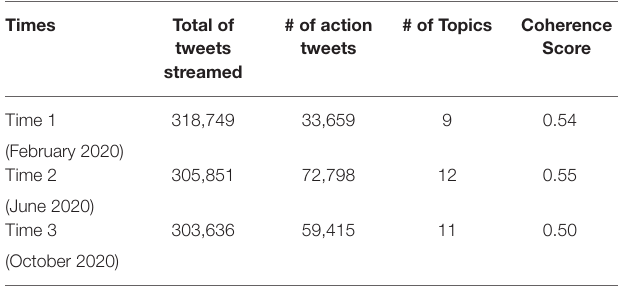
TABLE 2 | Overview of total tweets, “action” tweets, and topic modelling